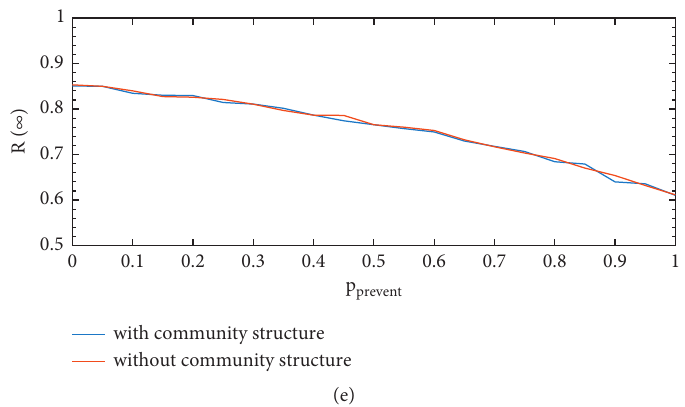
Figure 7: The influence of taking preventive behaviors on the coupled disease-awareness model. (a) Density of infected individuals in the physical layer as a function of time. (b) Density of recovered individuals in the physical layer as a function of time. (c) Density of aware individuals in the virtual layer as a function of time. (d) Density of recovered individuals in the virtual layer as a function of time. (e) The final density of recovered individuals in the physical layer under different probabilities of taking preventive behaviors for the virtual contact networks with or without community structure.